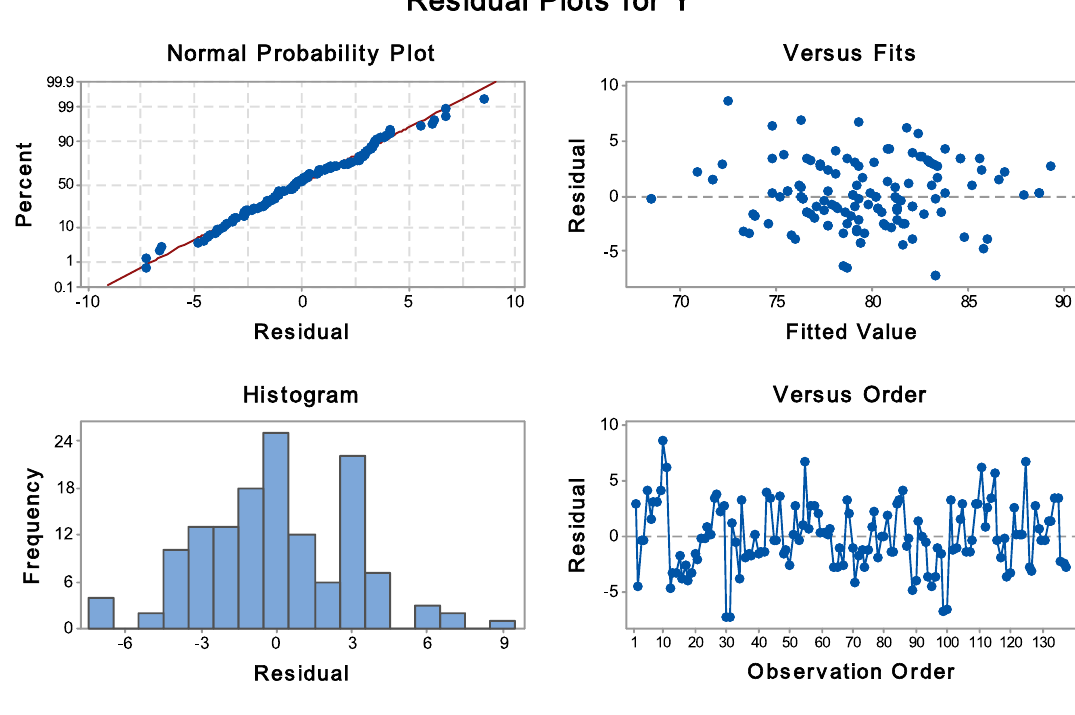
Fig. 9 Residual plots in model fitting for the second interval